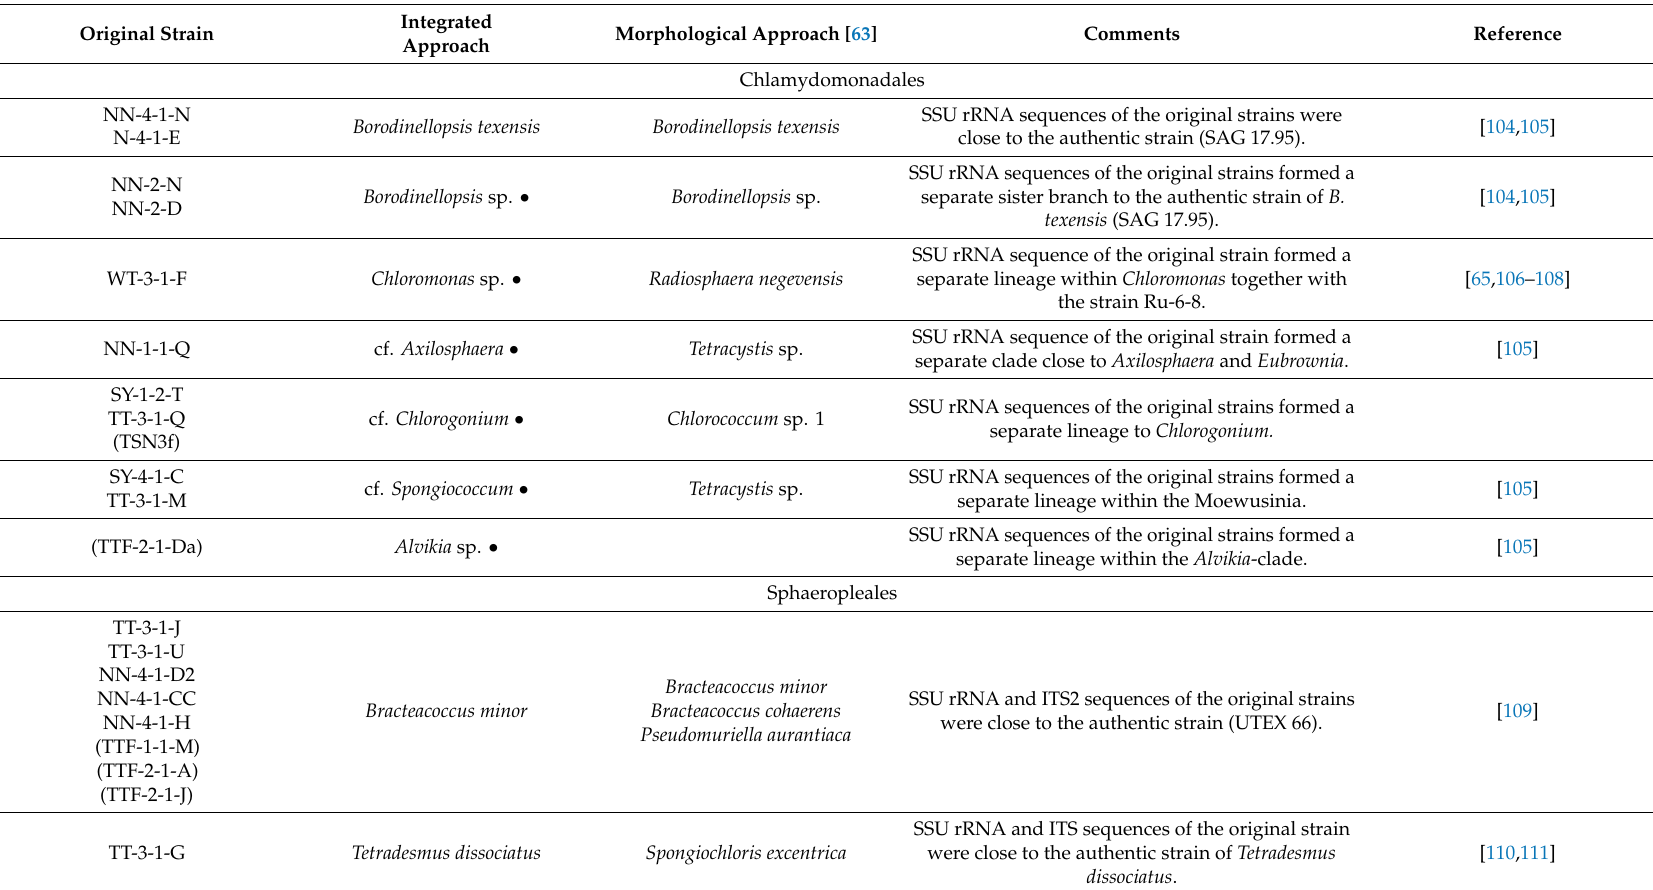
Table 1. Integrative species identifications compared to morphological identifications in a previous study [63]. Possibly undescribed taxa are marked ( • ). Additional strains that were not published and morphologically identified previously are placed in